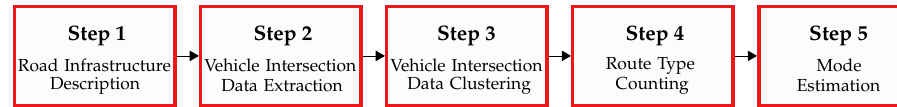
Figure 1. Sequence of operation of PROMOTING method.